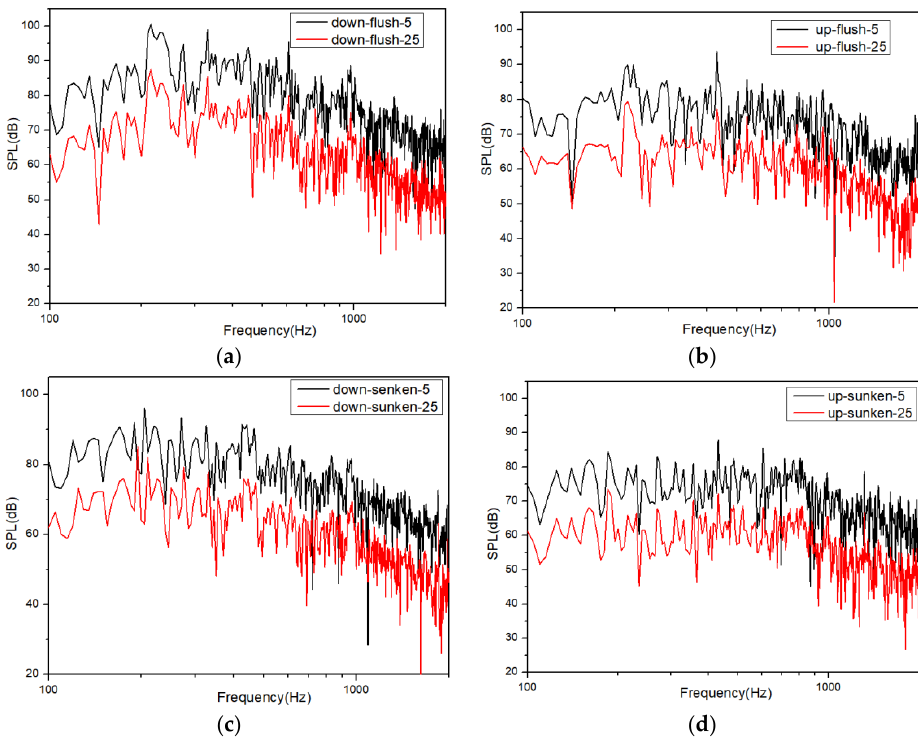
Figure 17. Noise predictions at the far field monitoring points. ( a ) Noise of down-pantograph with flush base; ( b ) Noise of up-pantograph with flush base; ( c ) Noise of down-pantograph with sunken base; and ( d ) Noise of up-pantograph with sunken base.